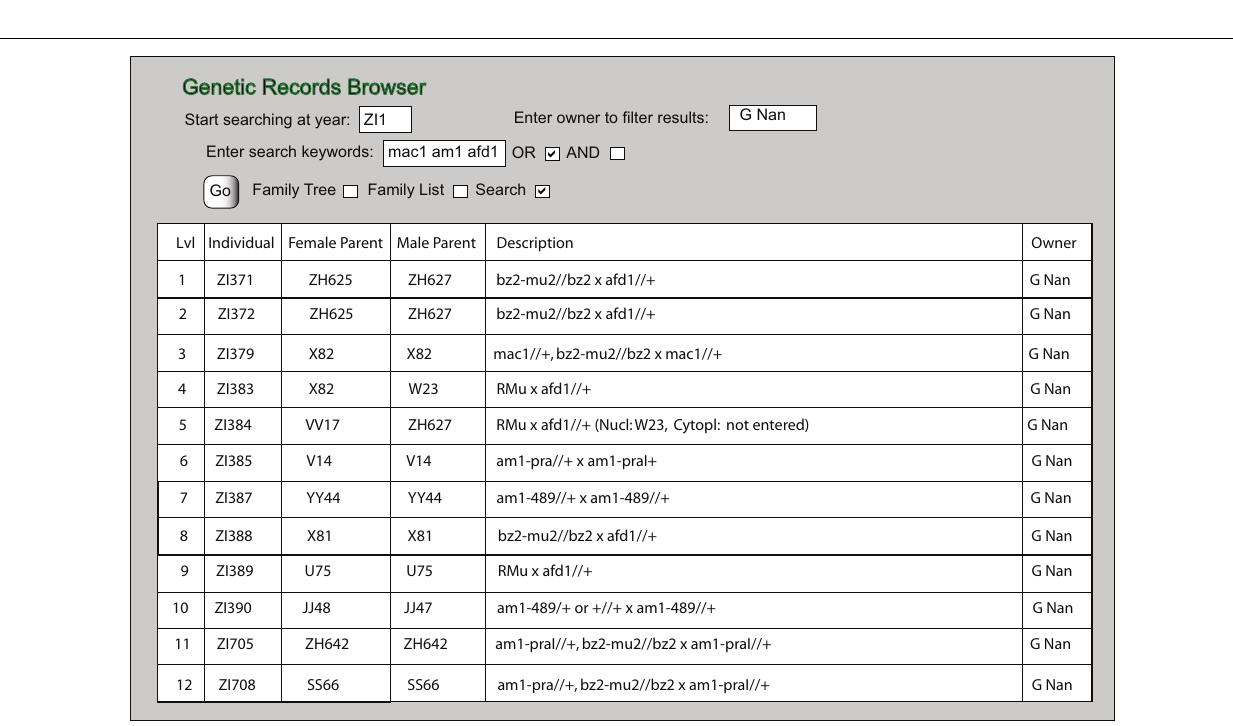
Genetic Records Browser